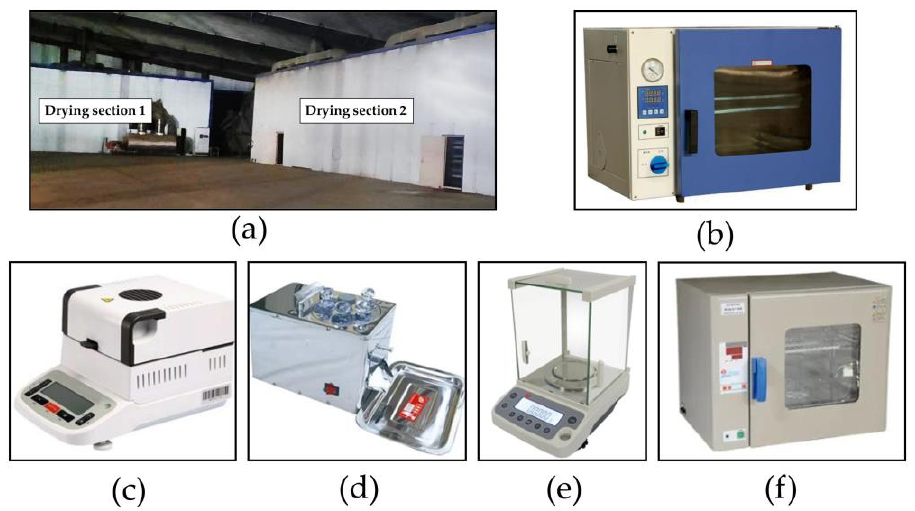
Figure 2. Instruments and equipment: ( a ) self-made Cyperus esculentus hot air tempering dryer; ( b )